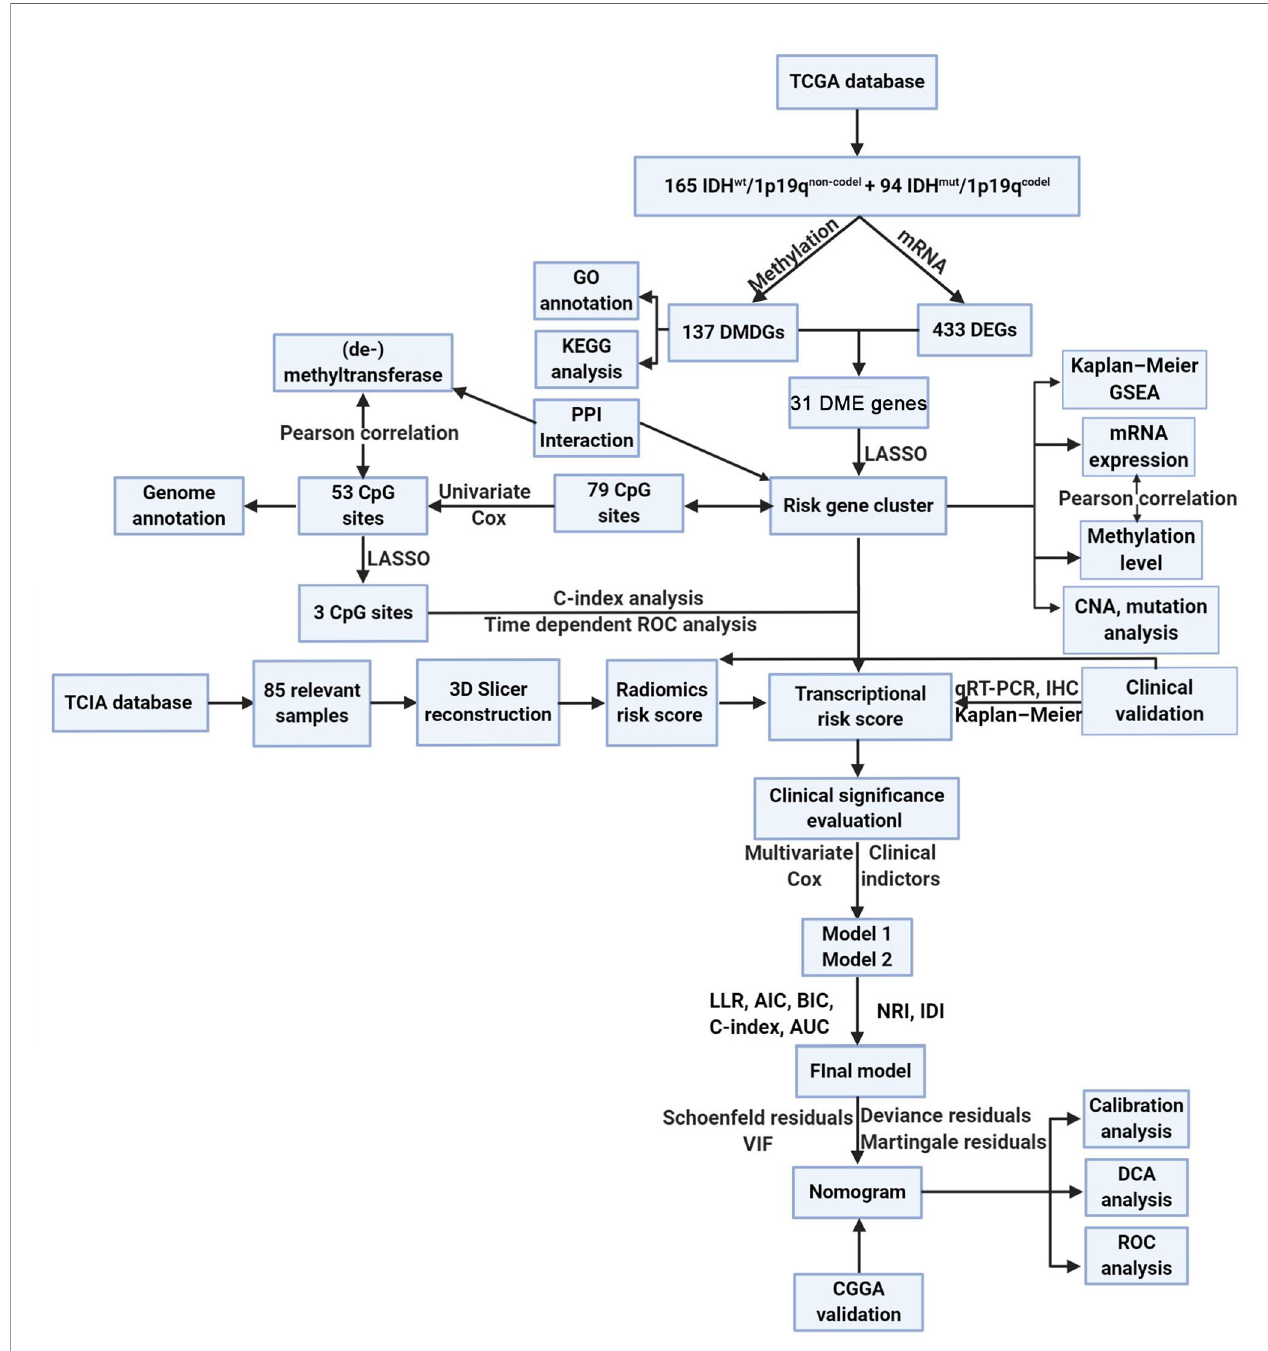
FIGURE 1 | The method of this